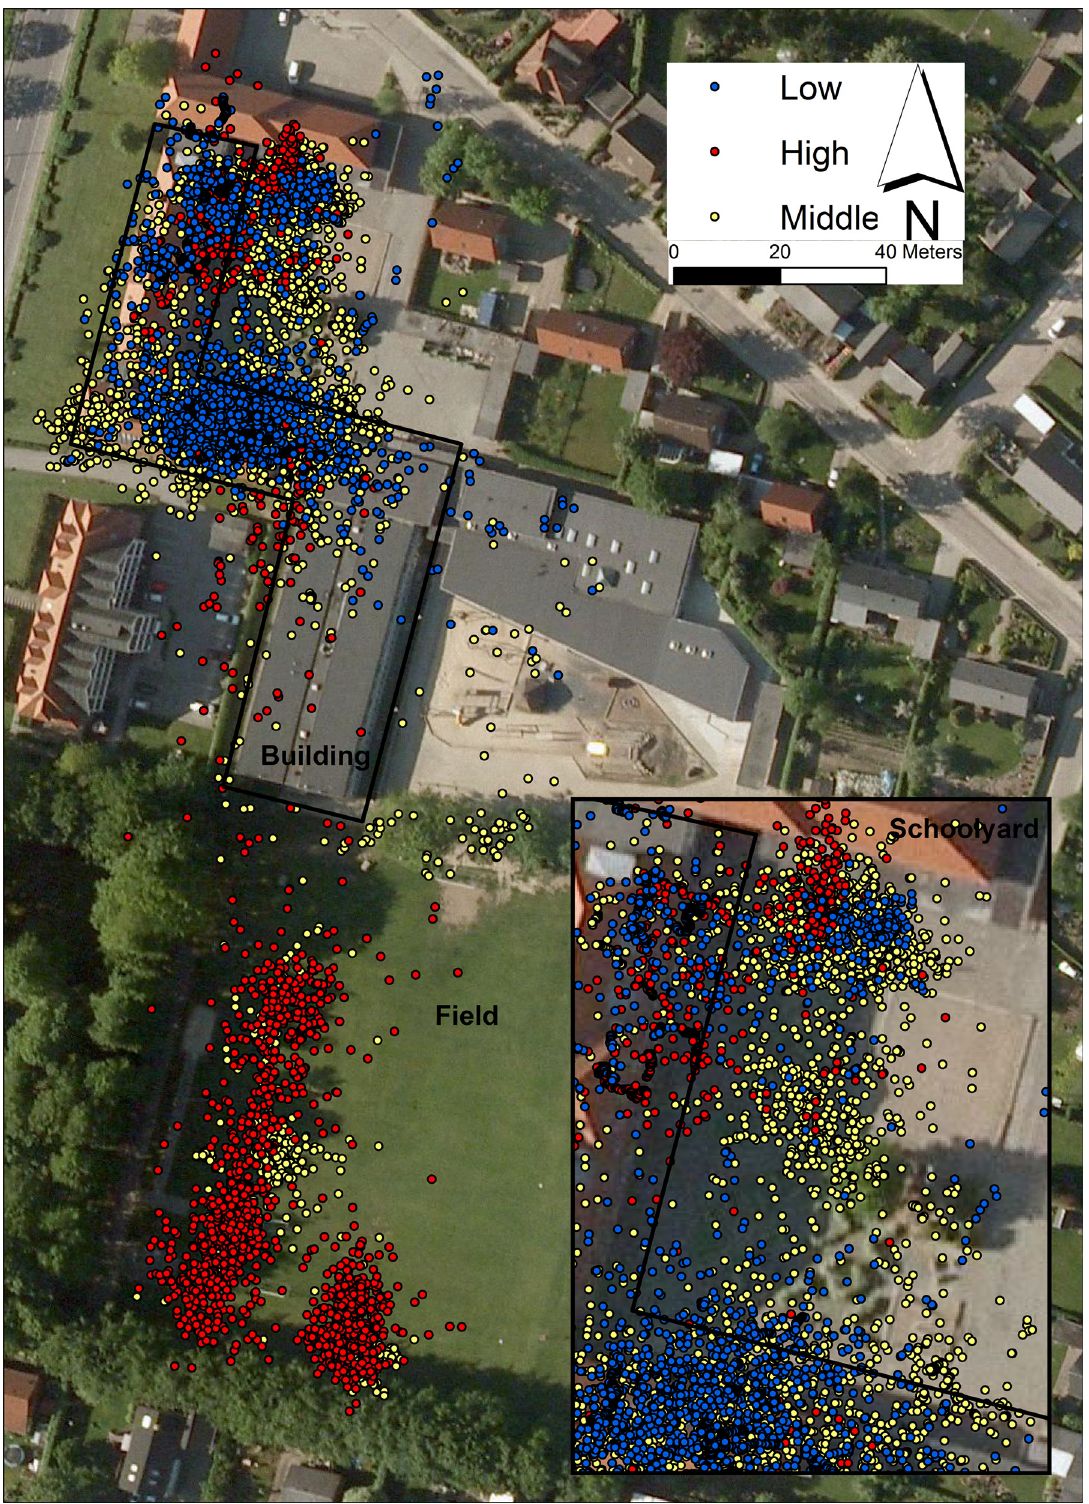
Fig 1. An example of where the Low, Middle and High PA groups were during recess. Contains data from the Danish Geodata Agency, Ortofoto, WMS.